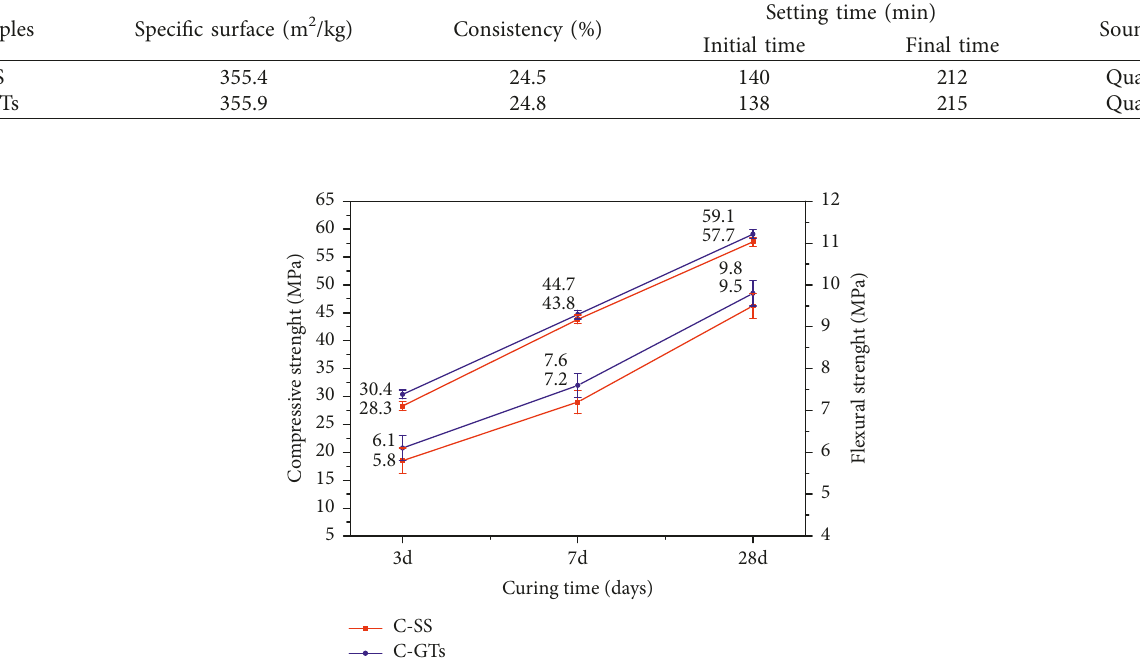
Figure 6: Compressive and flexural strengths of two cements with curing